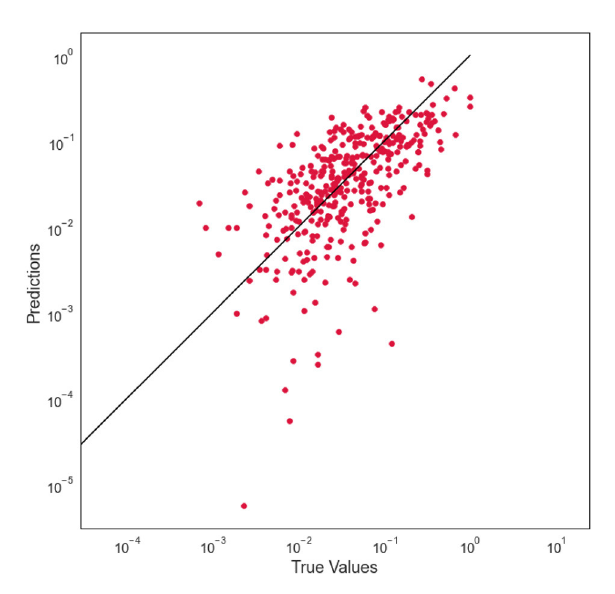
FIGURE7 Actual vs. predicted—spatial lag